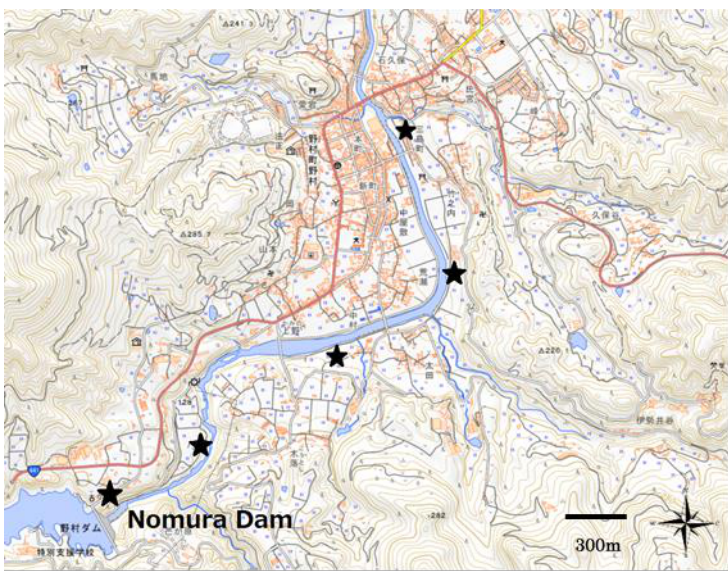
Figure 9. Location of loudspeakers in the inundated area of Seiyo. This map is based on a digital map